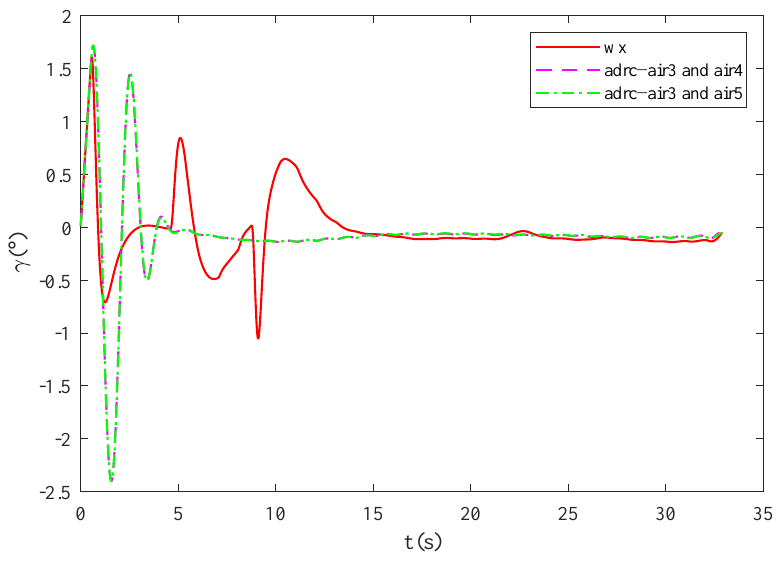
Figure 5. Roll angle response curve under the combination of two steerage deviation. Experiment 2: Based on centroid